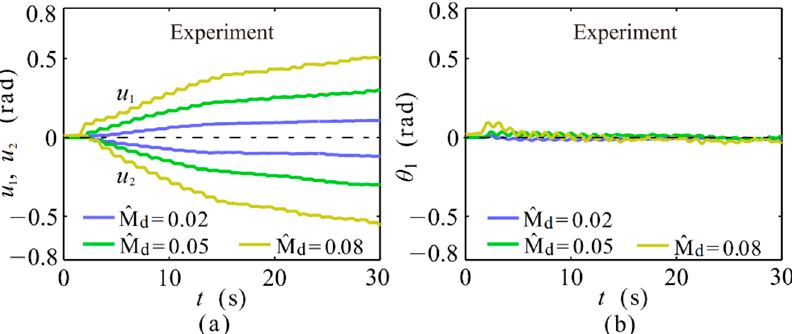
Figure 13. Serial-stiffness-switch system experiment results for harmonic disturbances under different disturbance torque amplitudes (cid:98) M d , here η s = 100 and η d = 3. ( a ) Deformations of the two springs, u 1 and u 2 ; (b) displacement of the primary plate, θ 1